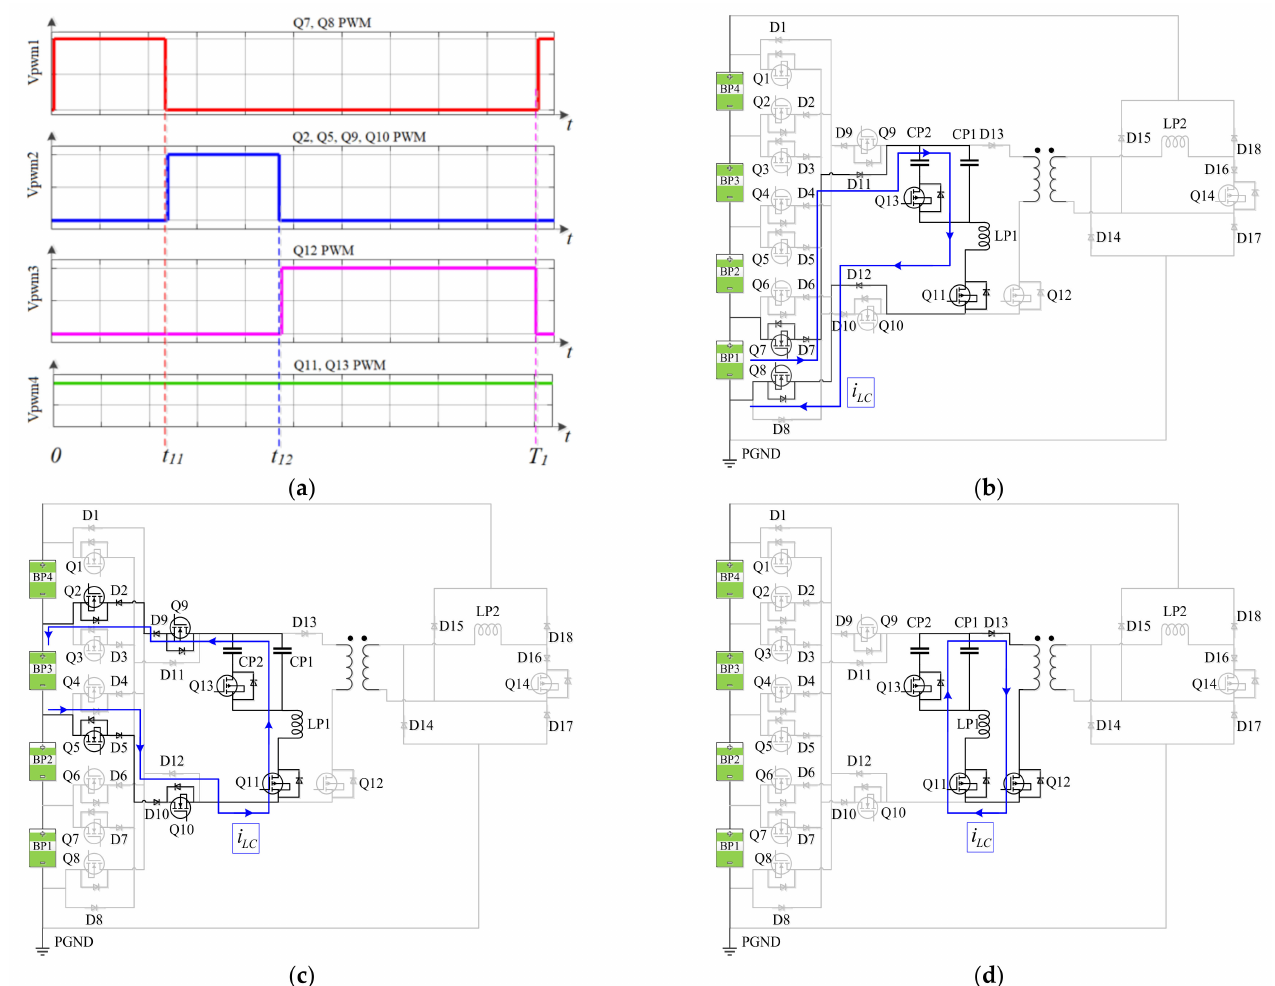
Figure 4. Operating principles of DP2P mode. ( a ) PWM wave sequence diagram of DP2P mode. ( b ) State I. ( c ) State II. ( d ) State